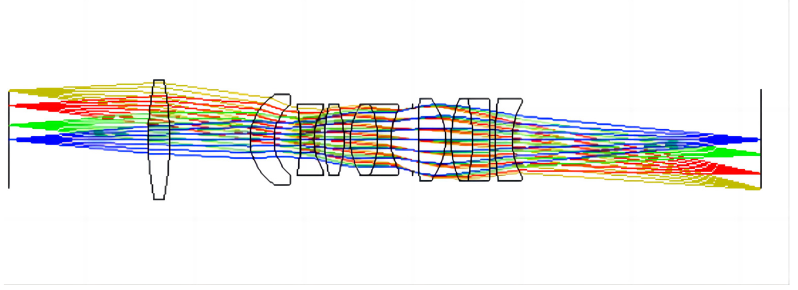
Figure 6. Layout of the refractive lens system.